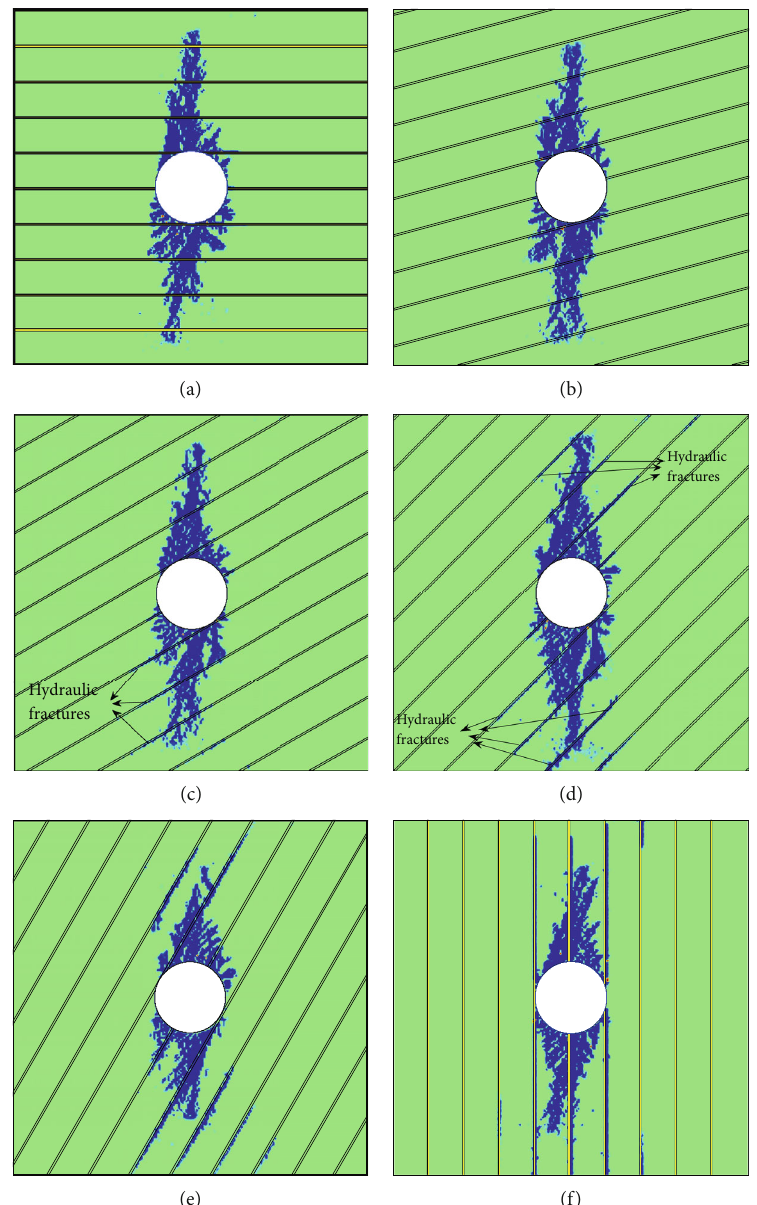
Figure 11: The distribution of hydraulic fractures in specimens with di ff erent bedding plane angles: (a) α = 0 ° , (b) α = 15 ° , (c) α = 30 ° , (d) α = 45 ° , (e) α = 60 ° , and (f) α = 90 °